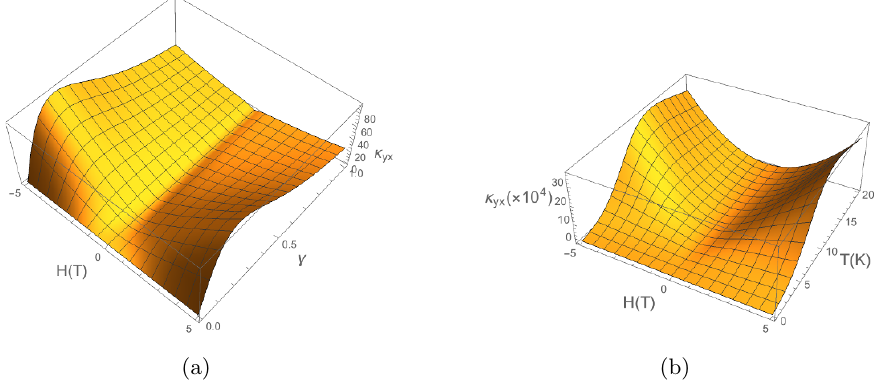
Figure 8 . Transverse thermal conductivity (cid:20) xy (a) as a function of Magnetic doping and magnetic (cid:12)eld at T = 2 K , (b) as a function of Temperature and magnetic (cid:12)eld at q (cid:31) .